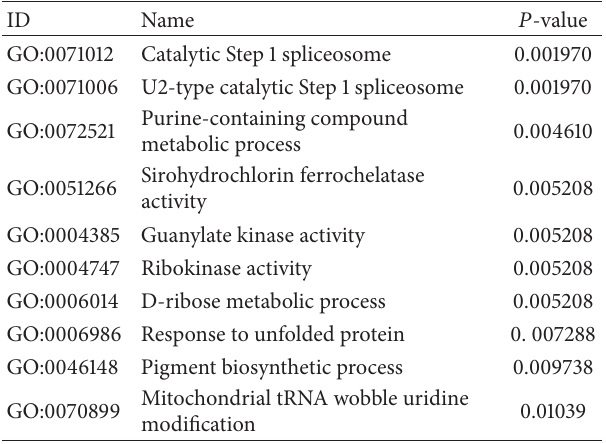
Table 5: GO analysis for tricluster TC 9 found in the Yeast Cell Cycle